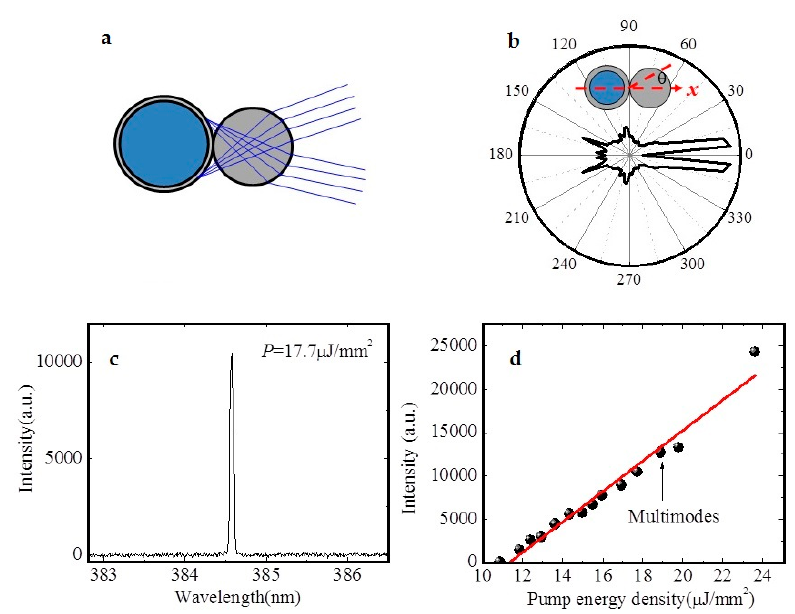
Figure 5. ( a ) Schematic of the focused light rays from the cylinder. ( b ) Far-field distribution of light. ( c ) Single wavelength lasing under lower pump power. ( d ) Plot of the relation between the output intensity and pump energy density [37].